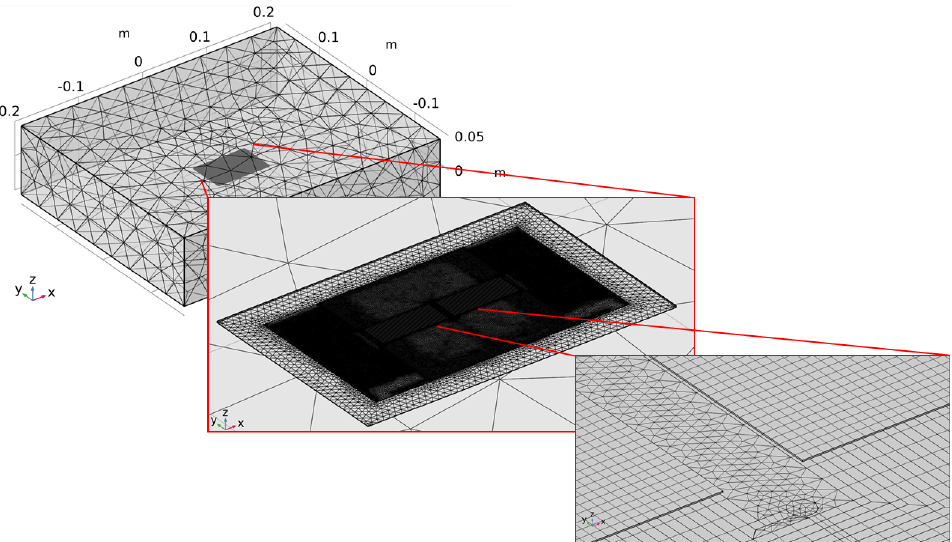
Figure 8. Mesh implemented for the PCFS model: the overall dimension of the air volume and different levels of detail (in red boxes) are shown.